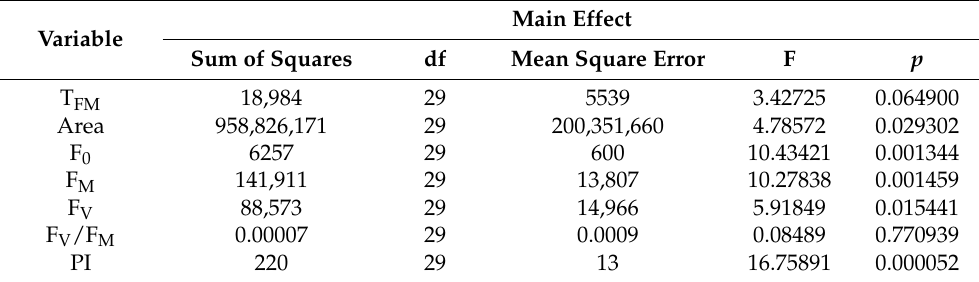
Figure 10. ‘Area’ parameter in the leaves of strawberry plants inoculated with rhizosphere bacteria growing under different substrate moisture levels, where: OM—optimal moisture, WD—water deficit. Table 4. ANOVA